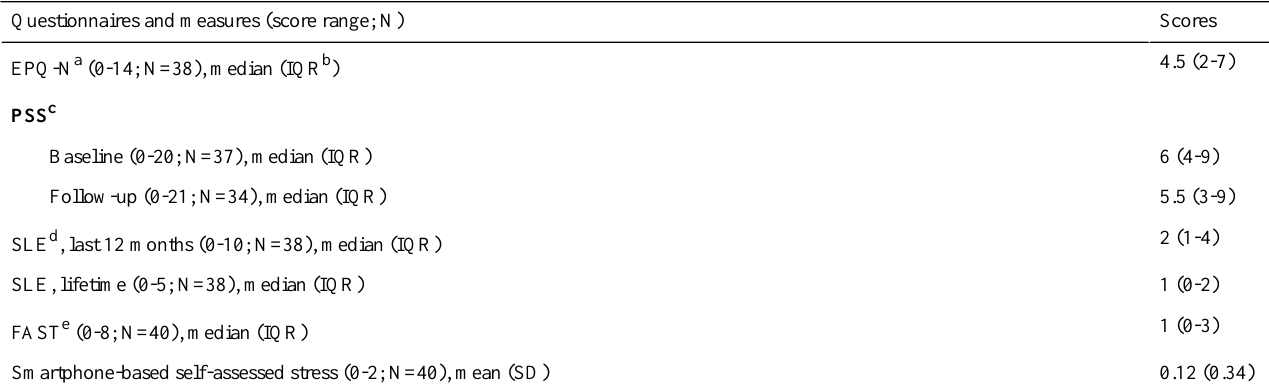
Table 2. Total scores on different questionnaires and smartphone-based self-assessed stress. ScoresQuestionnaires and measures (score range; N)